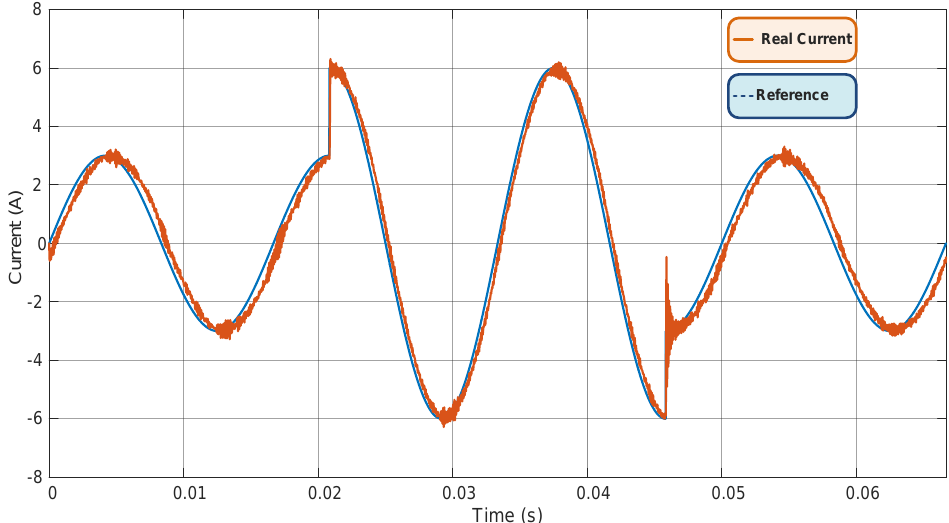
∗ using the signal function. 2 and i 2